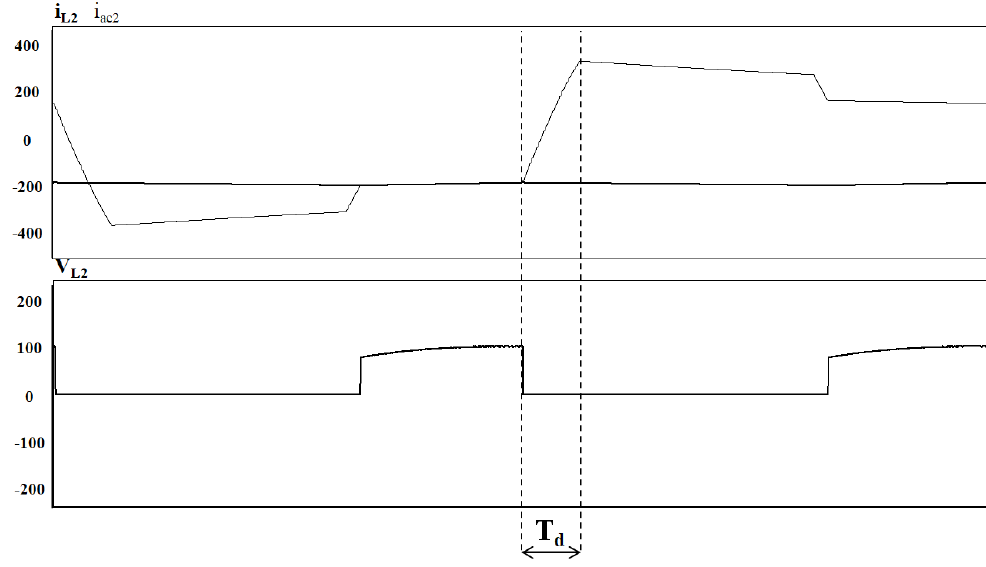
Figure 10. Zoom on the secondary-side waveforms for the modified PSM.